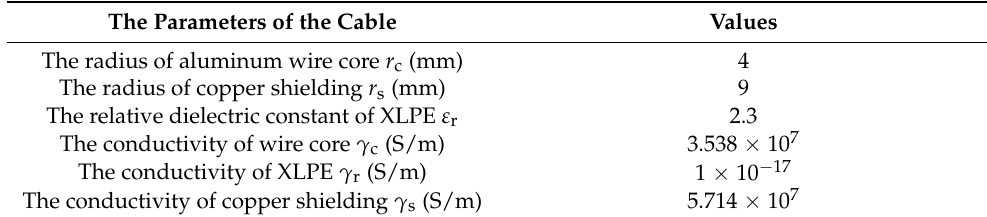
Table 1. The related parameters of the tested cable. The Parameters of the Cable Values The radius of aluminum wire core r c (mm) 4 The radius of copper shielding r s (mm) 9 The relative dielectric constant of XLPE ε r 2.3 The conductivity of wire core γ c (S/m) The conductivity of XLPE γ r (S/m) 1 × 10 − 17 The conductivity of copper shielding γ s